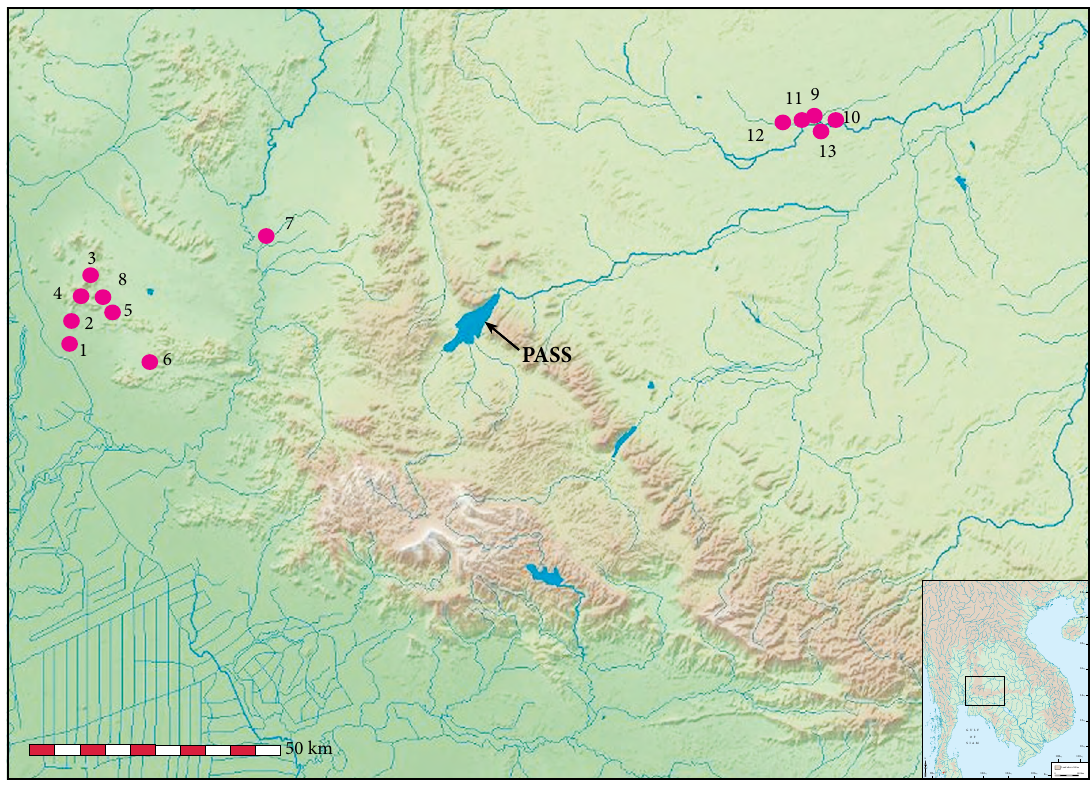
Fig. 1: The location of the two regions and the prehistoric sites. 1. Lopburi, 2. Tha Kae, 3. Non Pa Wai, 4. Nil Kham Haeng, 5. Huai Yai, 6. Khao Sai On, 7. Khok Charoen, 8. Non Mak La, 9. Ban Non Wat, 10. Ban Lum Khao, 11, Noen U-Loke, 12. Non Ban Jak, 13. Non Muang